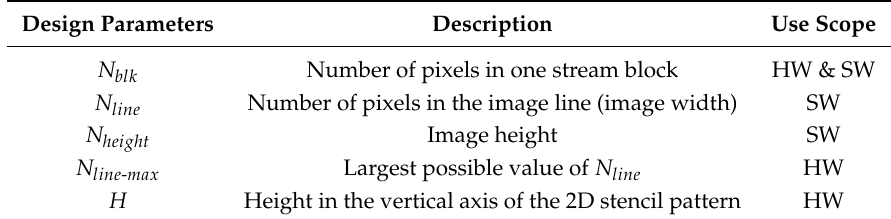
Table 1. Design parameters in D-SWIM